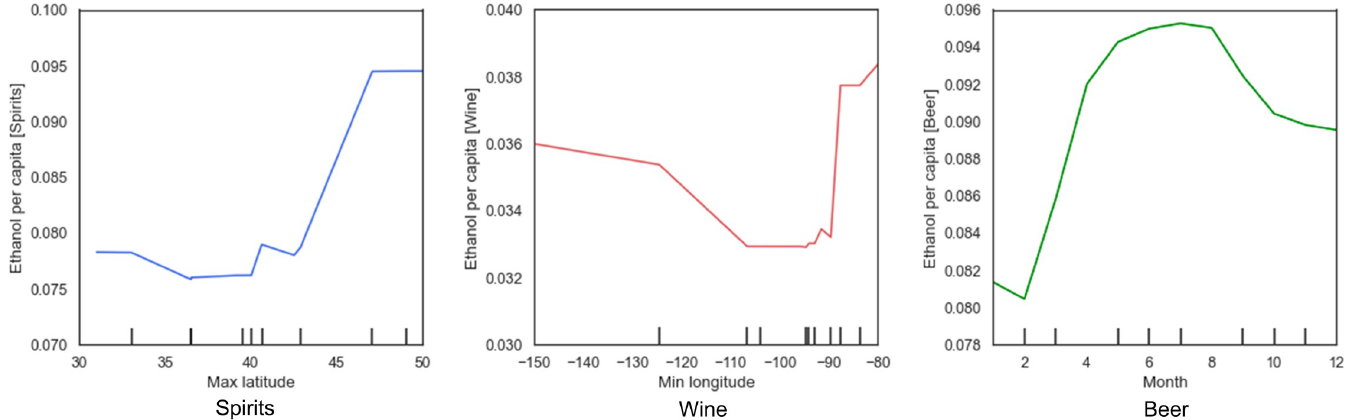
Fig 15. Partial dependence plots: (a) maximum latitude and spirits sales; (b) minimum longitude and wine sales; (c) month and beer sales.